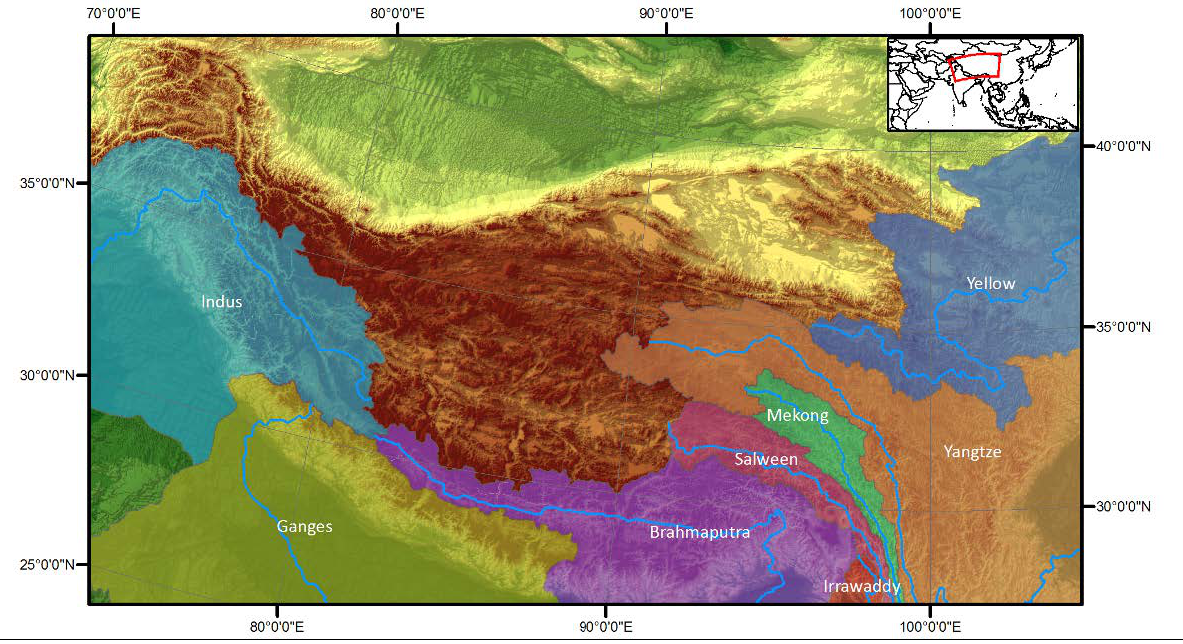
Figure 1. The Qinghai – Tibet Plateau and the main river Basins of South and East Asia (adapted from Menenti et al.